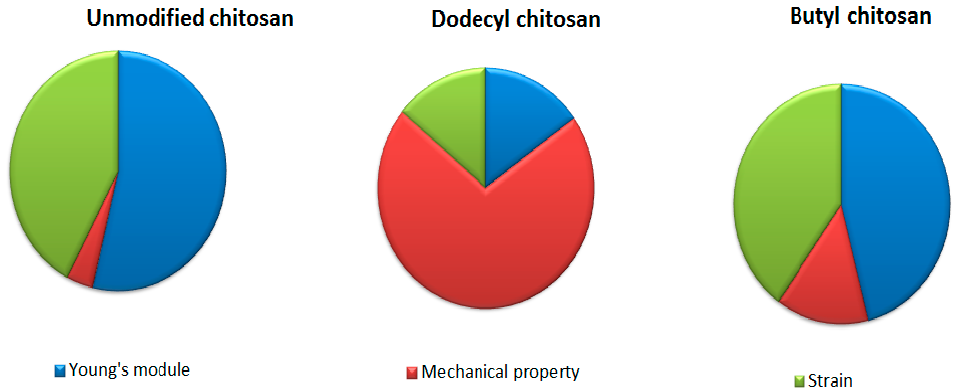
Figure 4. Comparative mechanical properties of chitosan and its